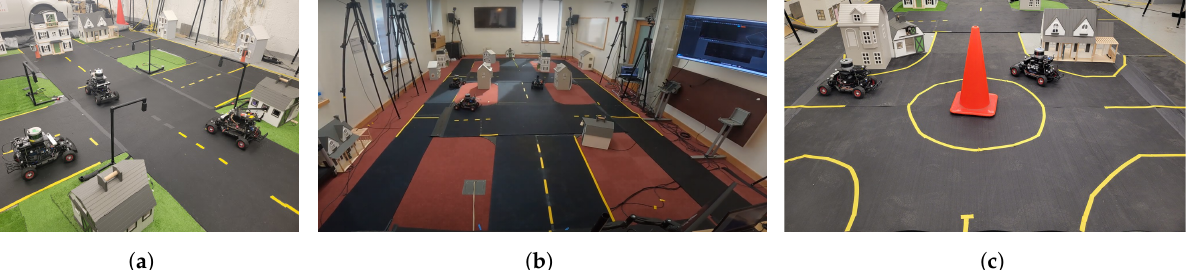
Figure 2. Three deployments of the MiniCity at MIT. ( a ) Small MiniCity; ( b ) Large MiniCity; ( c )